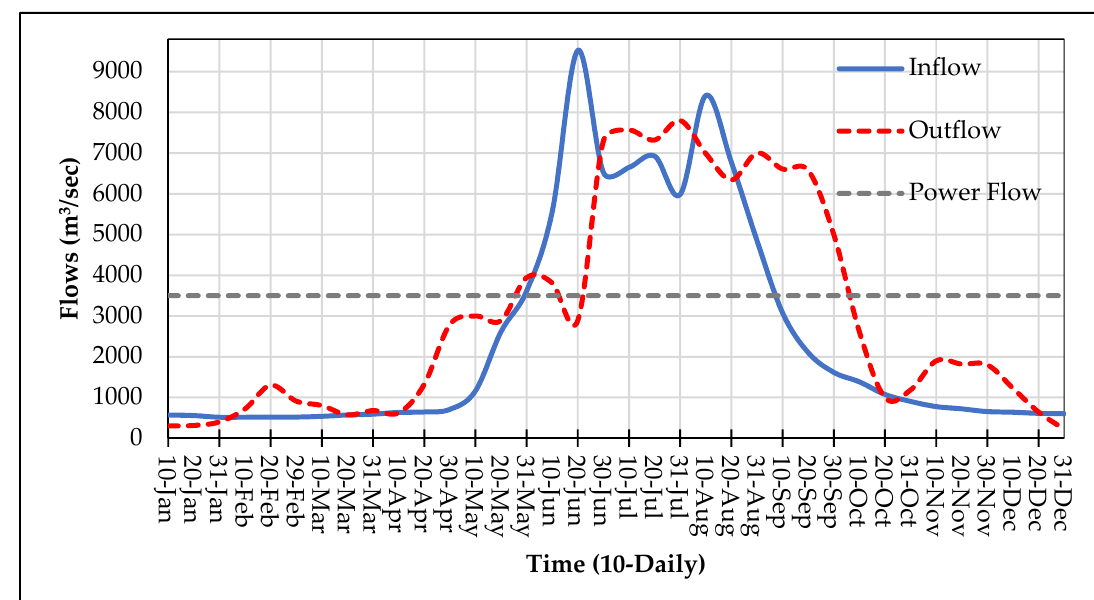
Figure 28. Inflow-Outflow Hydrograph of year 2008.